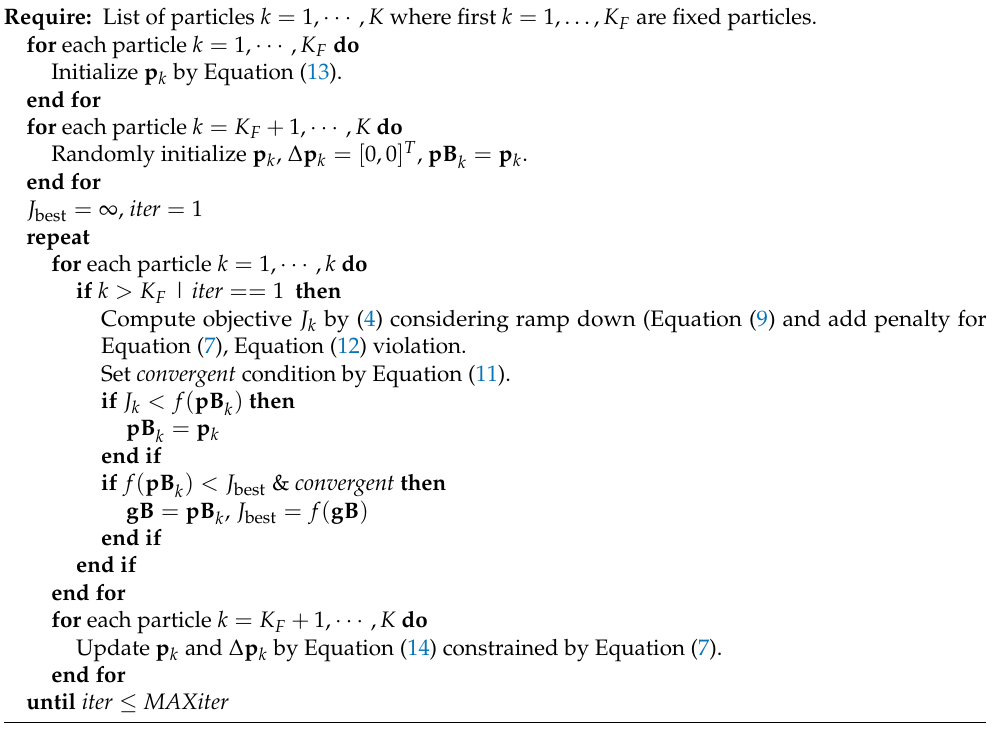
Algorithm 1 Combined deterministic-stochastic